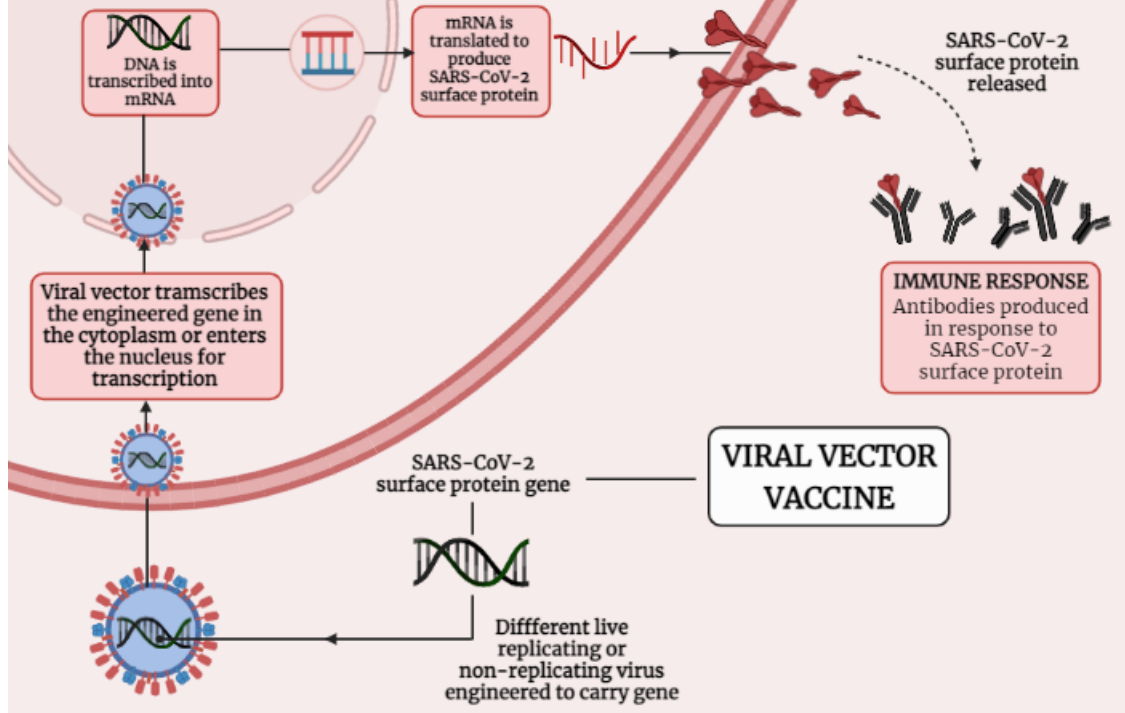
Figure 3. Shows the mechanism of Viral vector-based vaccine against